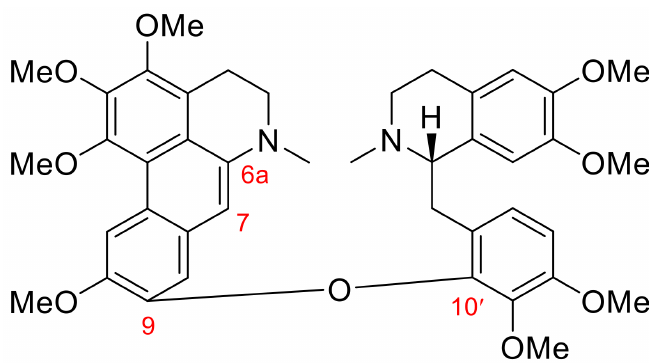
Figure 8. Structure of (+)-6a,7-dehydrohuangshanine ( 98 ).